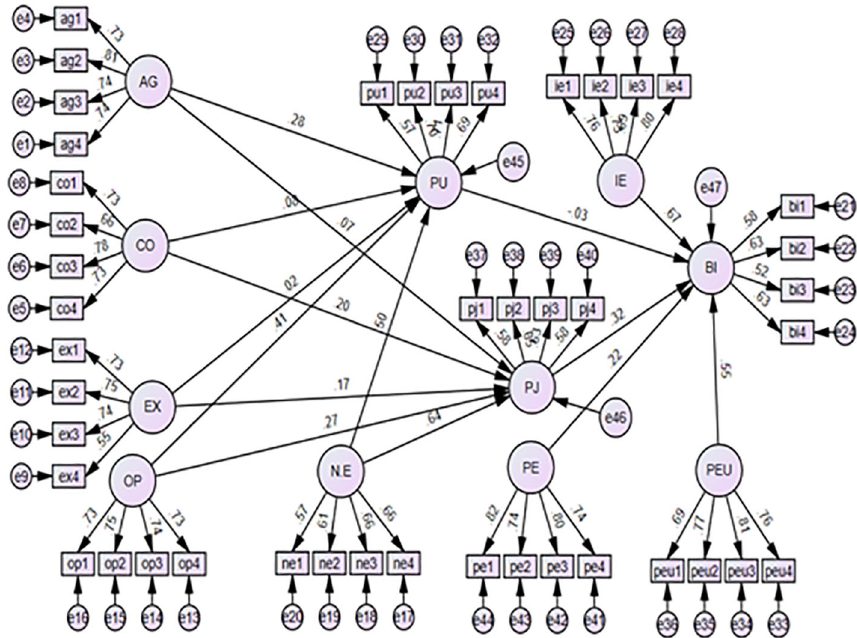
Figure 2. Confirmatory factor analysis